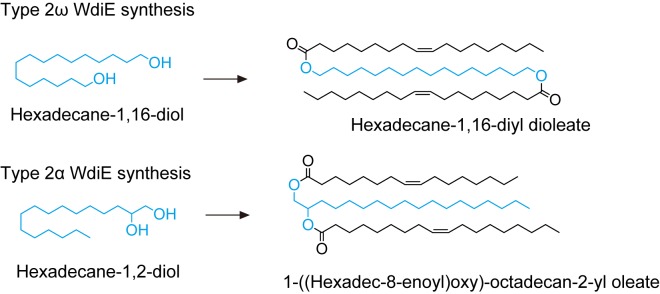
Synthesis schemes for type 2ω WdiE ([1,ω-O-C18:1]-C16:0) and type 2α WdiE ([1,α-O-C18:1]-C16:0).